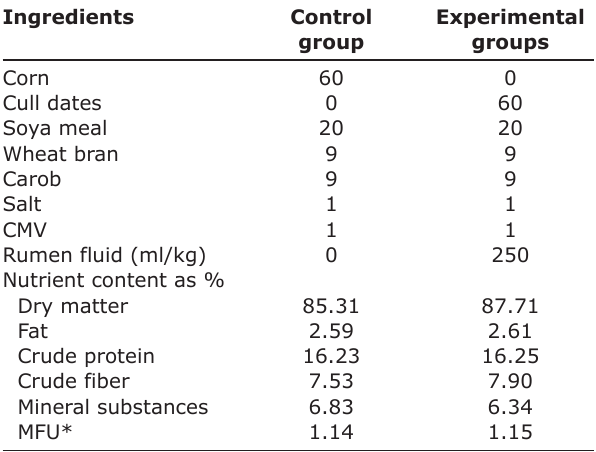
Table-5: Feed formulae of the additional rations (in % 100 of feed).